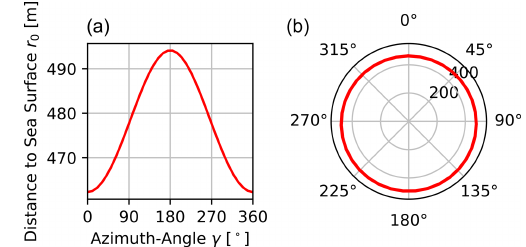
Figure 6. Modelled distances to the sea surface for an example set of parameters ( h = 25m, φ = 0 . 1 ◦ , ρ = 0 . 0 ◦ , γ ∈ [ 0 , 360 [ , ε ssl = − 3 ◦ ) on a regular plot (a) and a polar plot (b)